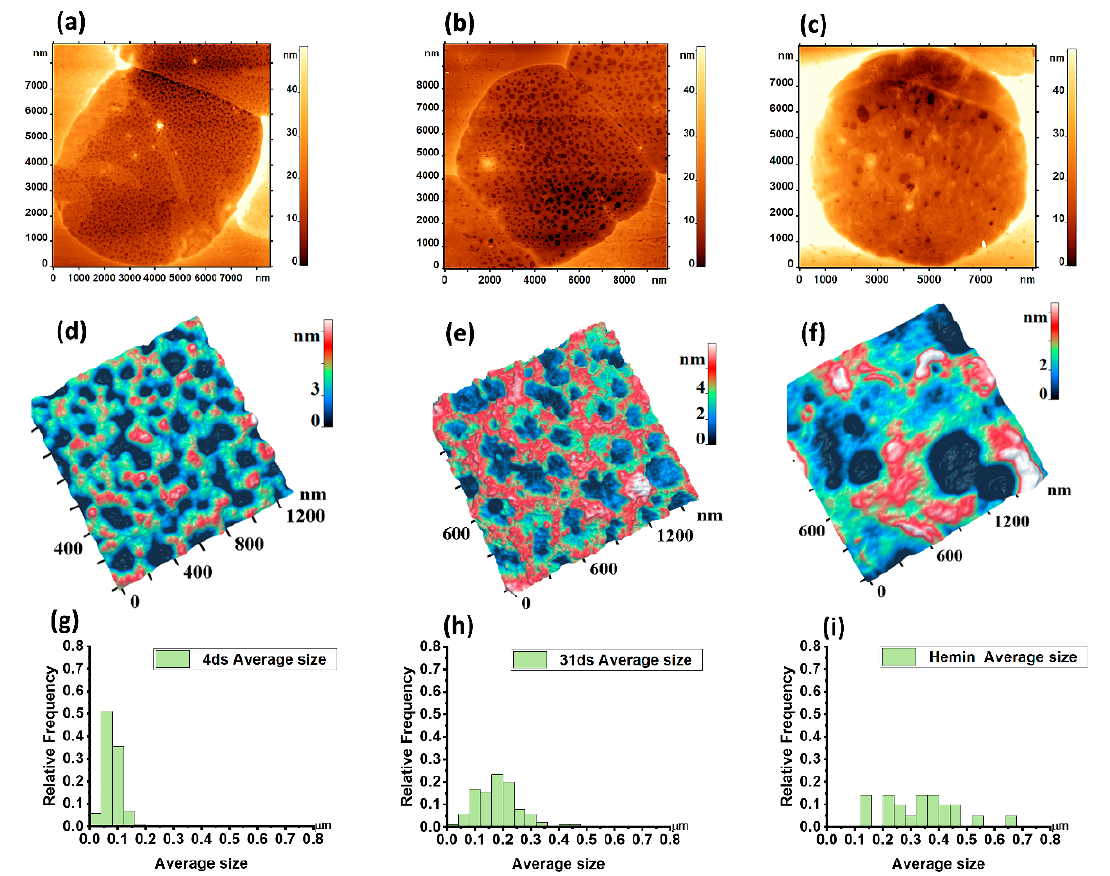
Figure 4. 2D AFM image of a ghost cell: ( a ) Day 4 of storage; ( b ) Day 31 of storage; ( c ) After exposure to hemin. 3D AFM image of the cytoskeleton fragment: ( d ) Day 4 of storage; ( e ) Day 31 of storage; ( f ) After exposure to hemin. Histograms for the average size of ghost fragments are given: ( g ) Day 4 of storage; ( h ) Day 31 of storage; ( i ) After exposure to hemin.